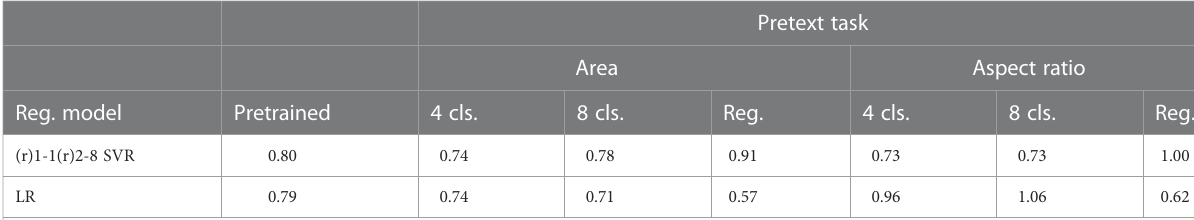
TABLE 1 MAE of estimation results when using SVR and LR.